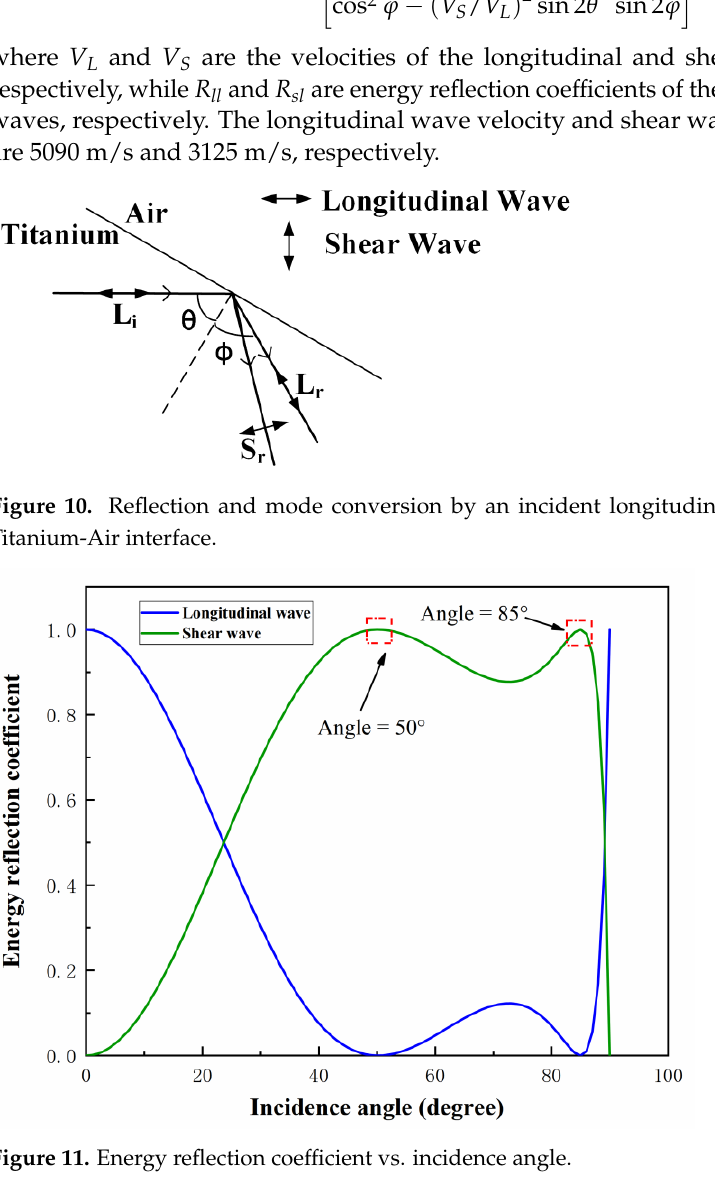
Figure 11. Energy reflection coefficient vs. incidence angle.